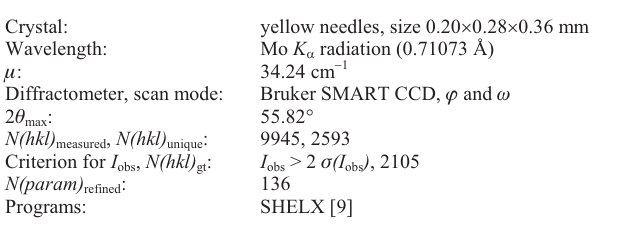
Table 1. Data collection and handling.